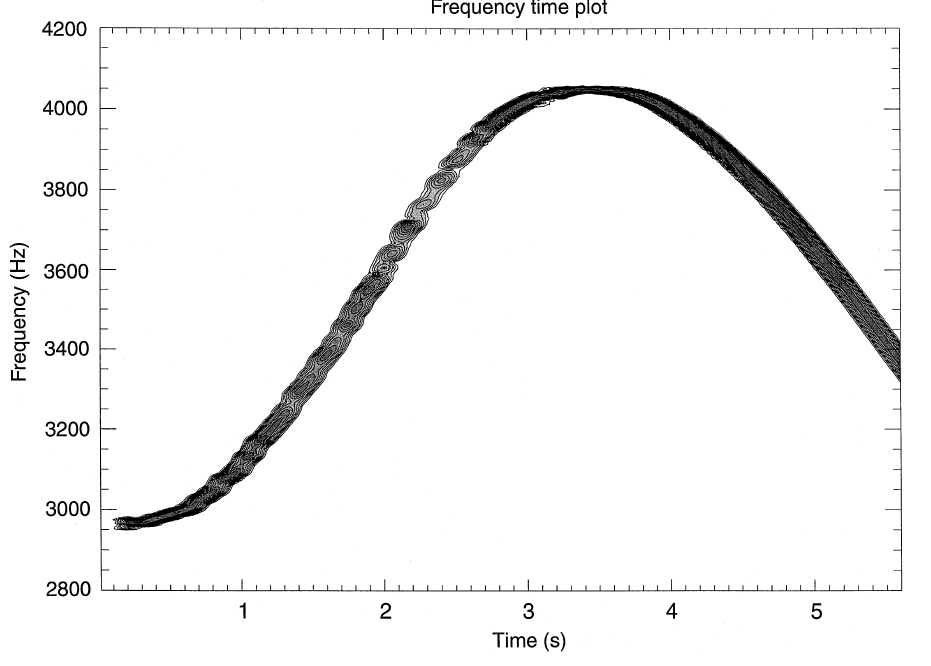
Fig. 14. Case C. Downward hook. Frequency/time diagram of the exit wave field. At t = 3 s the riser GR transforms itself into a faller GR. At higher frequencies the higher linear growth rates cause the wave profile to creep upstream, which triggers the